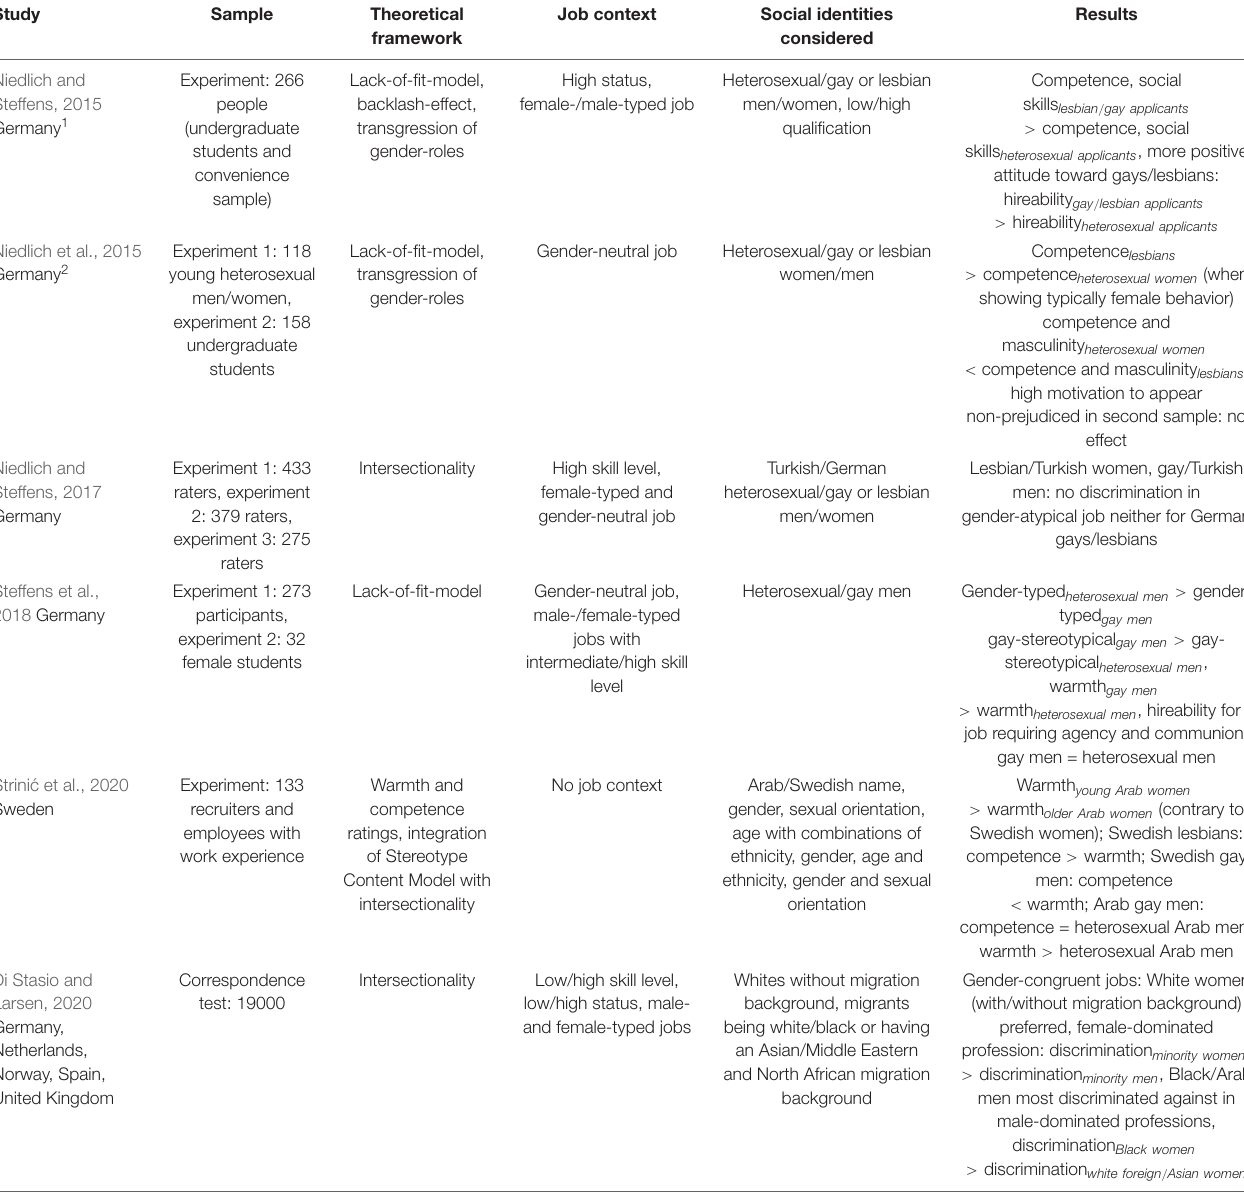
TABLE 6 | Overview of European social psychological studies on labor market discrimination based on the theory of intersectional